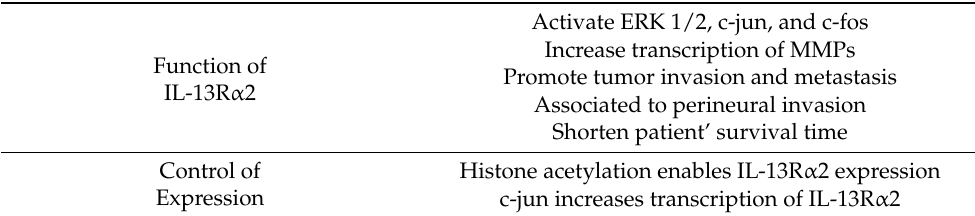
Activate ERK 1/2, c-jun, and